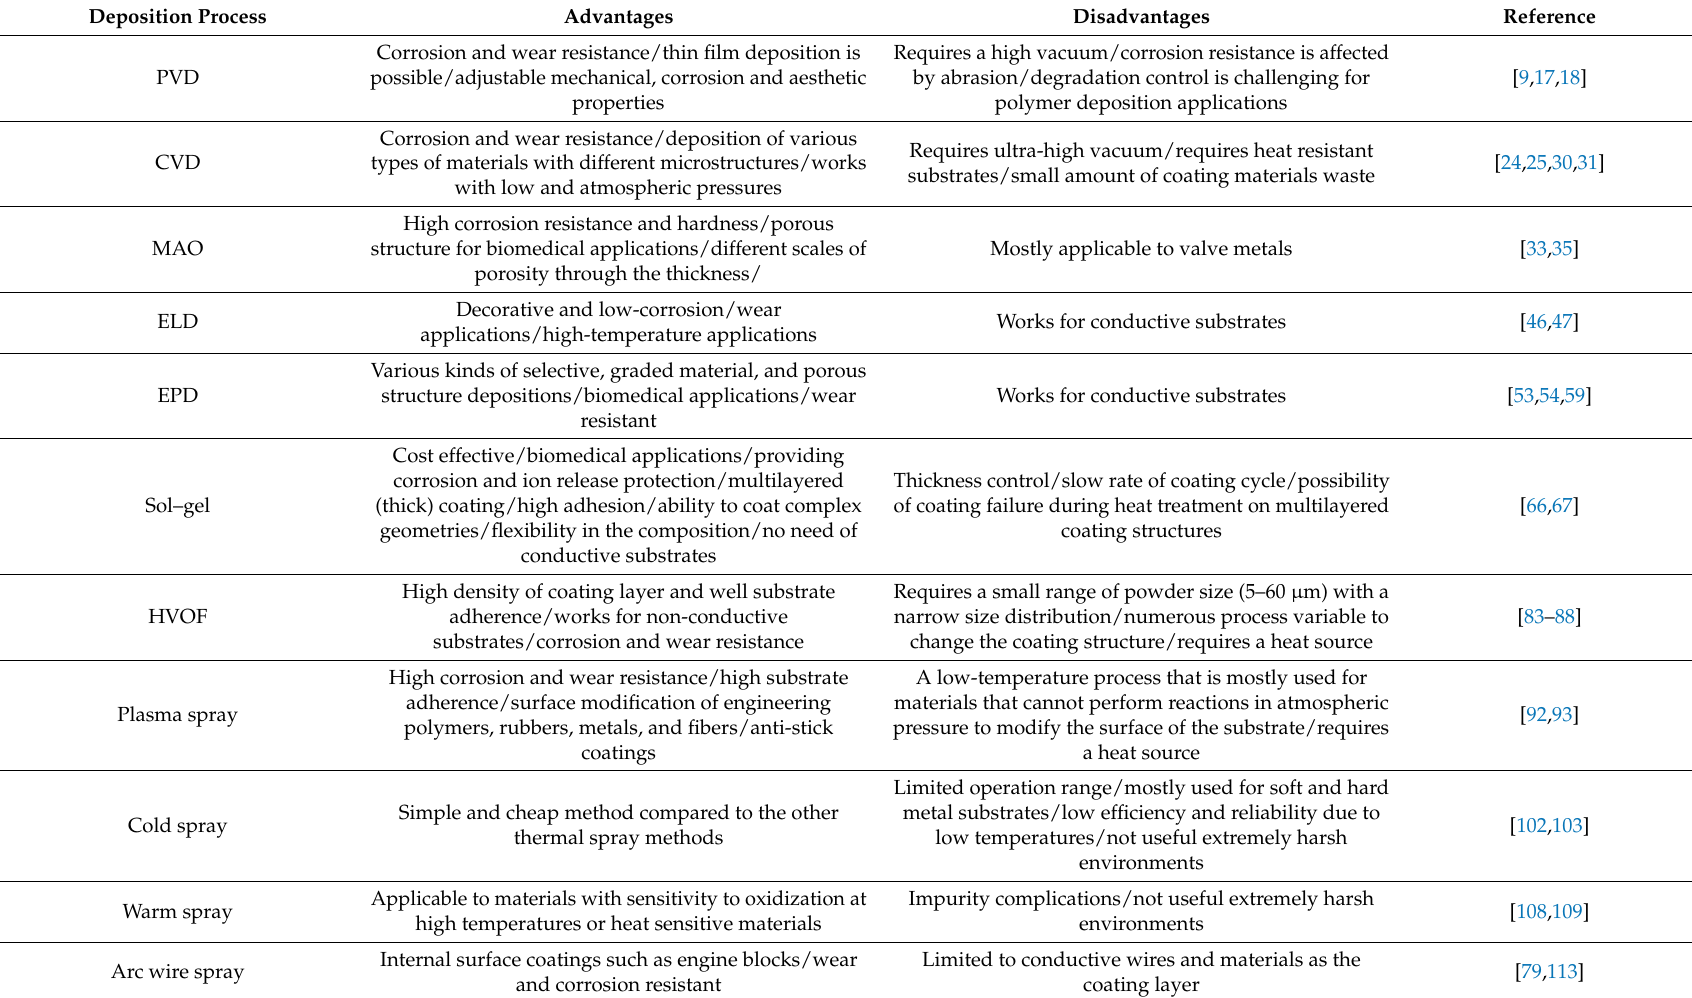
Table 4. Advantages and disadvantages of reliable coating